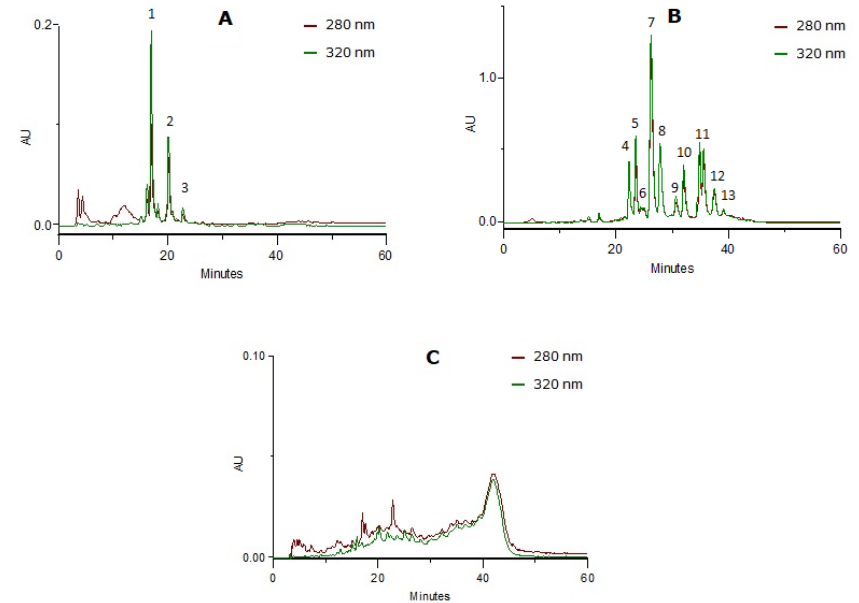
Figure 2. HPLC-PDA profiles at 280 nm and 320 nm from the enriched-fractions in phenolic com- pounds: ( A ) Phenolic acids (peaks 1 and 2: caffeic or ferulic acid derivatives; peak 3: p -coumaric acid derivative); ( B ) flavonoids (peaks 4, 6 to 9 and 11 to 13: luteolin derivatives; peaks 5 and 10: apigenin derivatives); ( C )